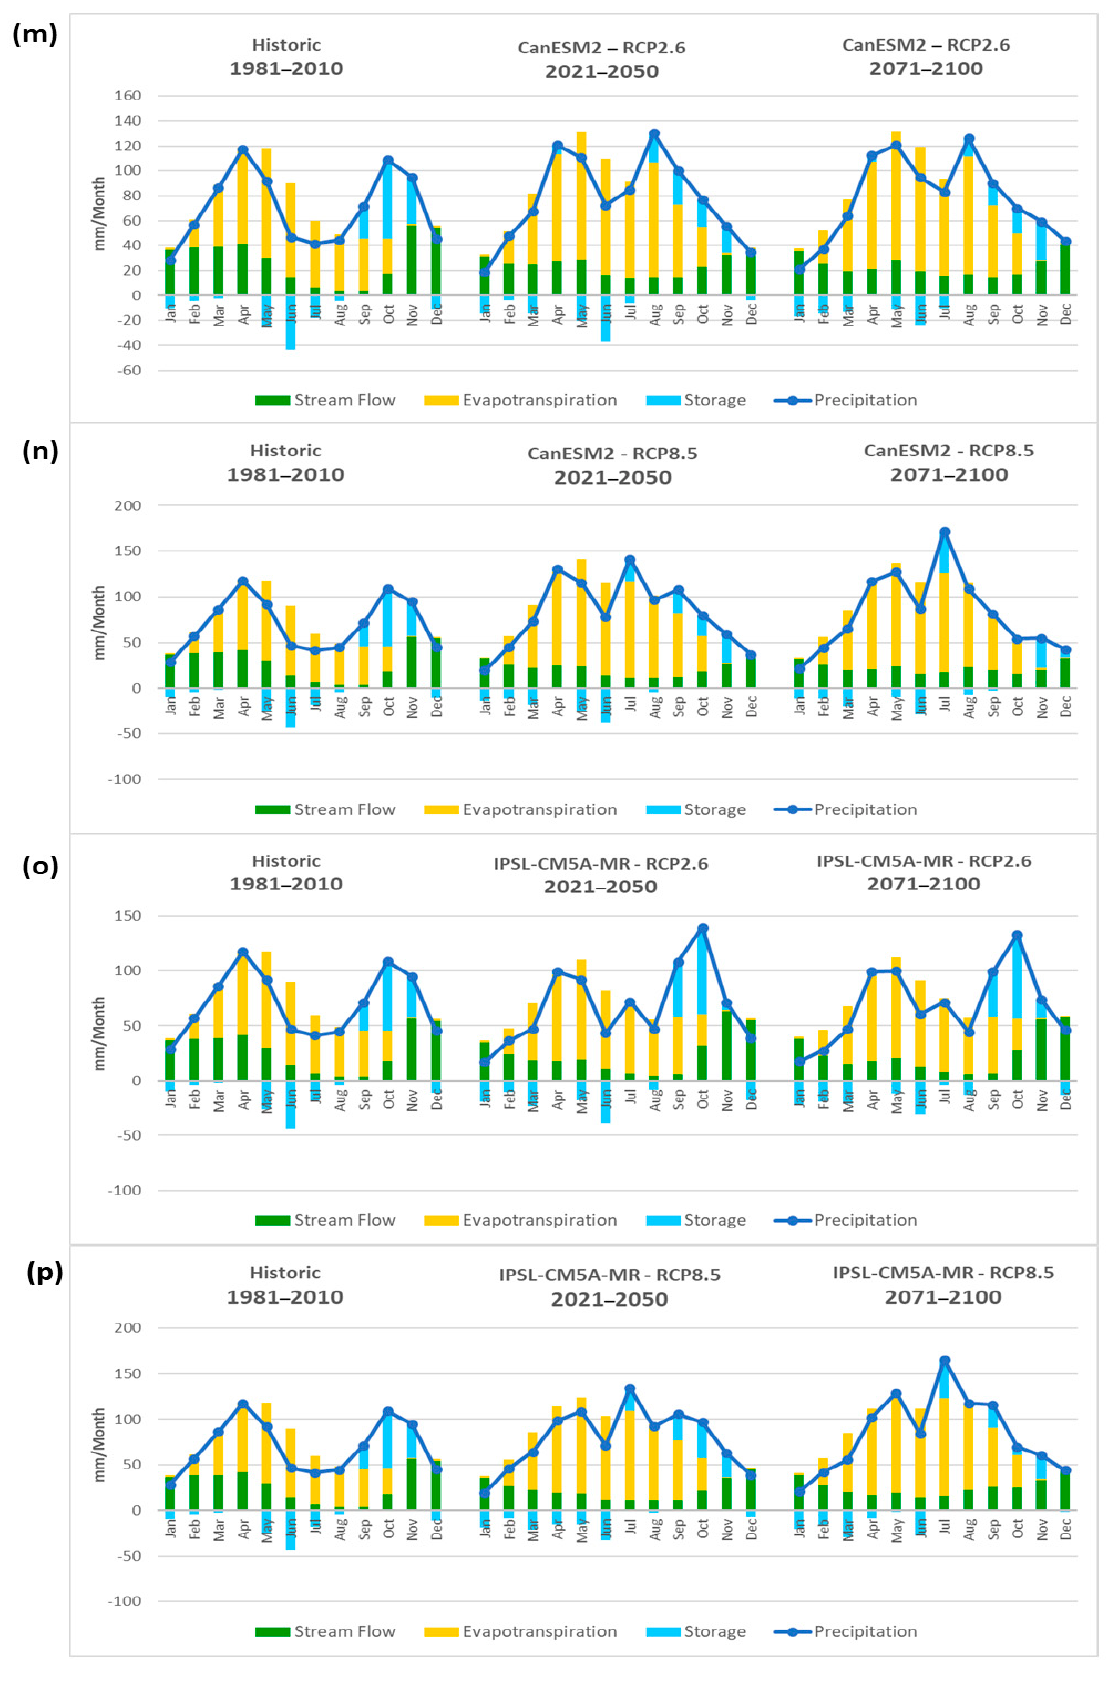
Figure A4. Sabana de Bogota